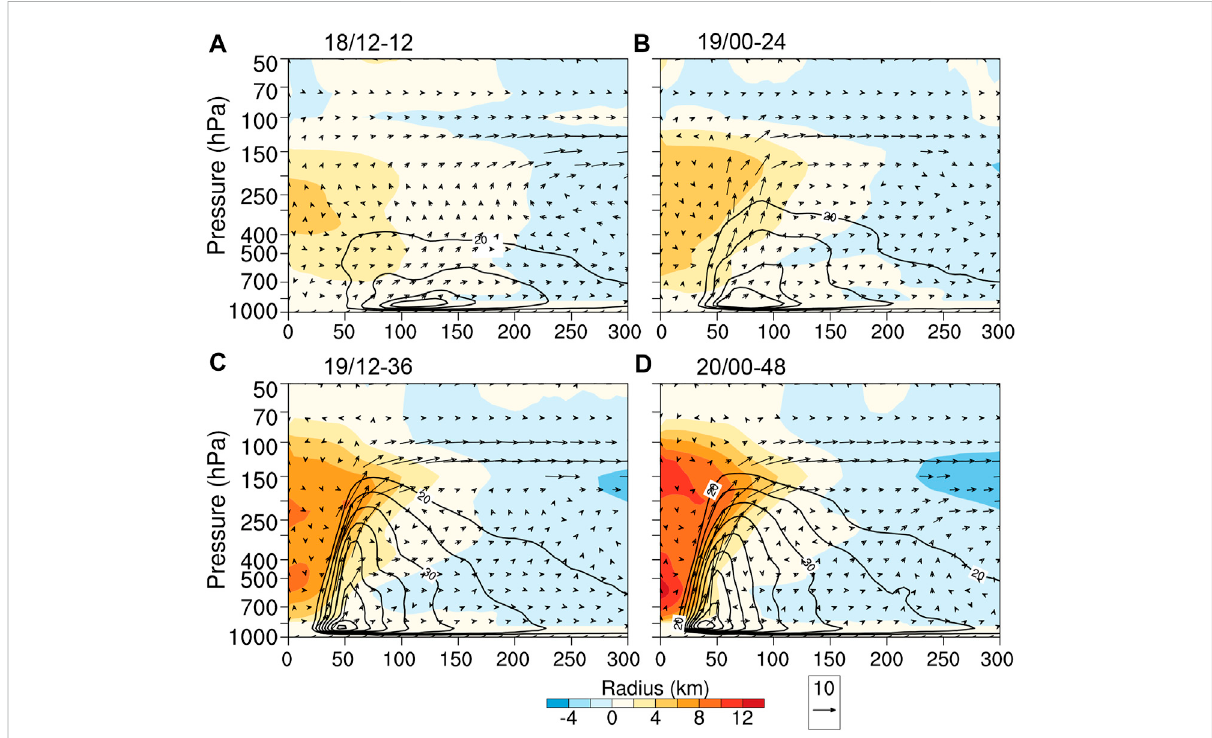
FIGURE 5 Radius-pressure plots of the azimuthally averaged potential temperature anomaly (shaded areas, K), tangential wind (contours, m s − 1 ) and radial-vertical wind velocity (vectors, m s − 1 ; vertical velocity multiplied by 10) for (A) 12-h integration (1200 UTC 18 September), (B) 24-h integration (0000 UTC 19 September), (C) 36-h integration (1200 UTC 19 September) and (D) 48-h integration (0000 UTC 20